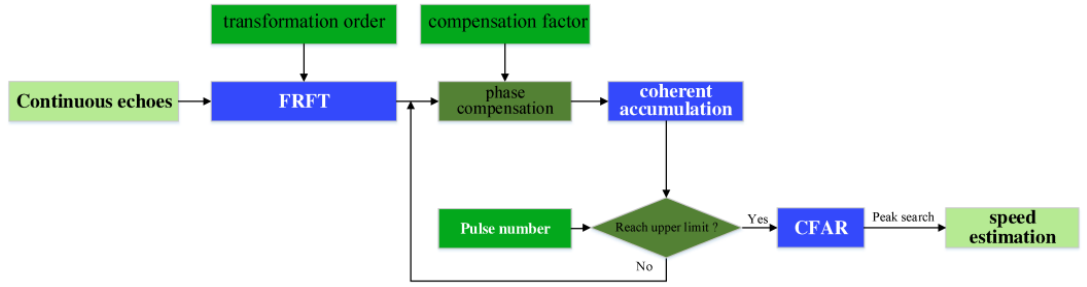
Figure 1. Flowchart of proposed